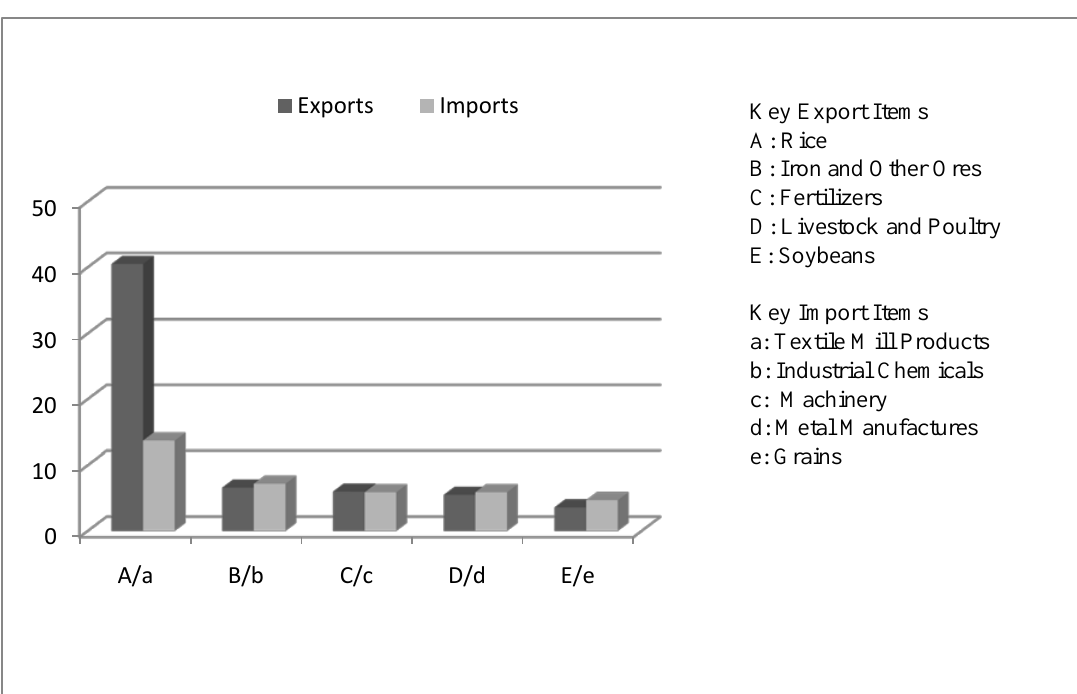
Figure 2. Korea's International Trade (Annual Average in %, 1934-37)